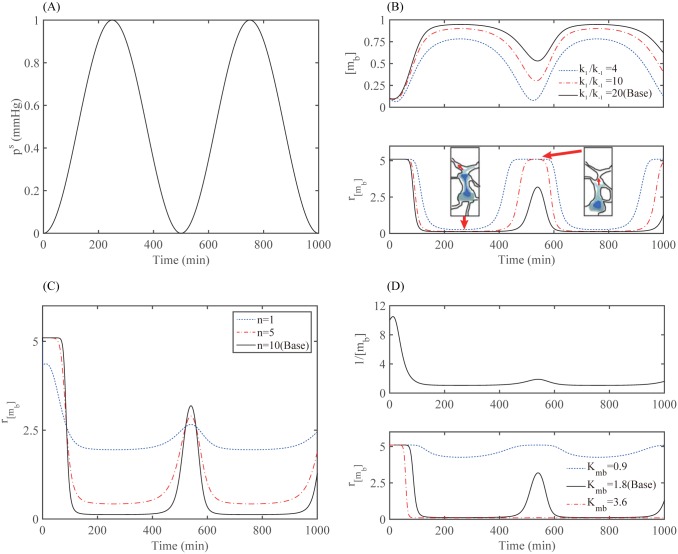
Dynamics of the acto-myosin module in response to fluctuating sensing pressure in the microenvironment.(A) Periodic sensing pressure averaged over the cell membrane. (B) Time courses of myosin II concentrations ([mb]; upper panel) and stiffening rates of the nucleus (r[mb]; lower panel) for various ratios of K (K = k1/k−1 = 4, 10, 20) in response to the fluctuating sensing pressure ps(t) in (A). (C) Time courses of stiffening rates of the nucleus for various Hill coefficient (n = 1, 5, 10) in response to the fluctuating sensing pressure ps(t) in (A). (D) Time courses of 1/[mb] (upper panel) and stiffening rates of the nucleus (r[mb]; lower panel) for various values of Kmb (Kmb = 0.9, 1.8, 3.6) in response to the fluctuating sensing pressure ps(t) in (A).